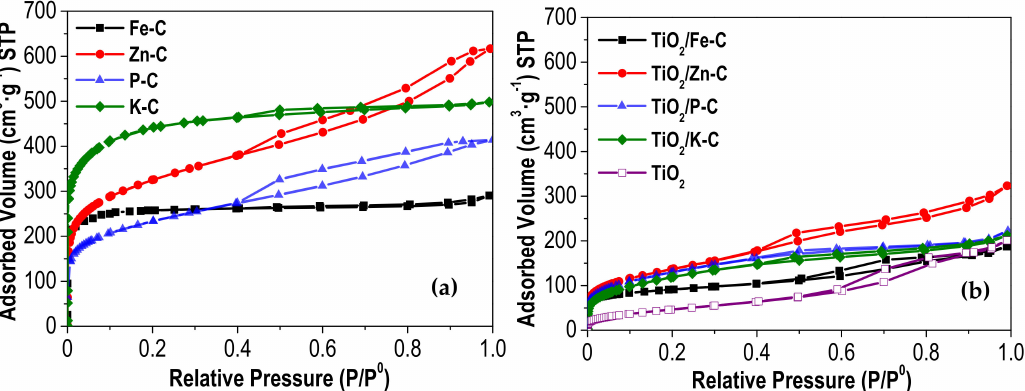
Figure 3. N 2 adsorption-desorption isotherms ( − 196 ◦ C) of ( a ) activated carbons and ( b ) TiO 2 and TiO 2 /x-C